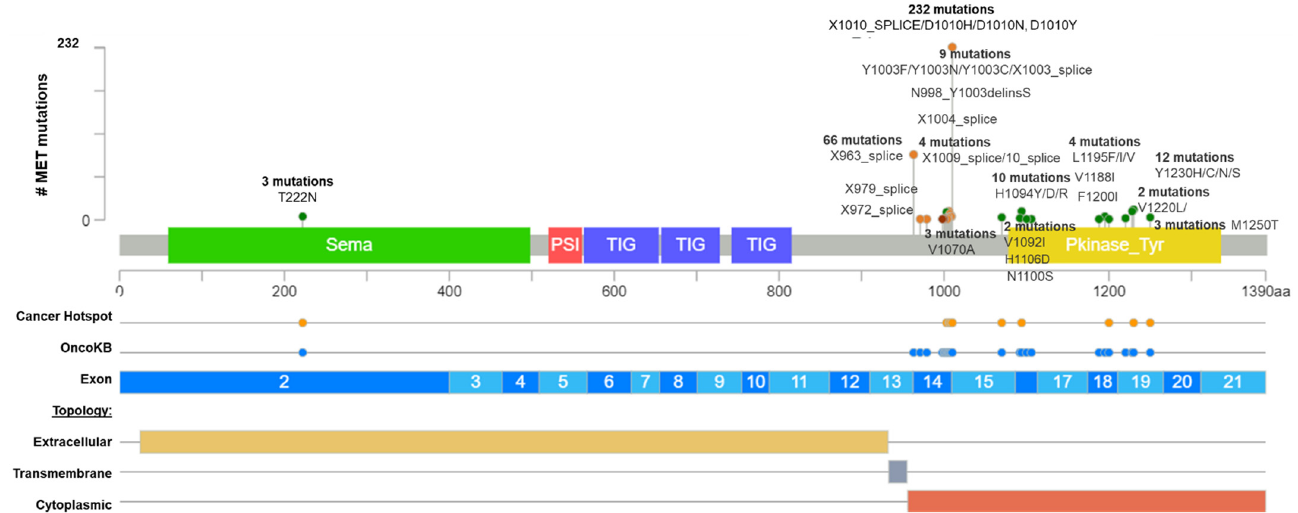
Figure 1. Common MET driver mutations impact principally the juxtamembrane and kinase domains (exon 14). Lolliplot of MET protein domains (Sema, PSI, TIG, juxtamembrane, and Pkinase) showing common driver mutations identified in solid tumors from Table 1. Additionally, the protein structure shows the cancer hotspot (yellow circle), OncoKB prediction therapies (blue circles), exons numbered (blue and light blue rectangles), and protein topology. Yellow is the extracellular region, red, the cytoplasmic region, and, gray, the transmembrane region.